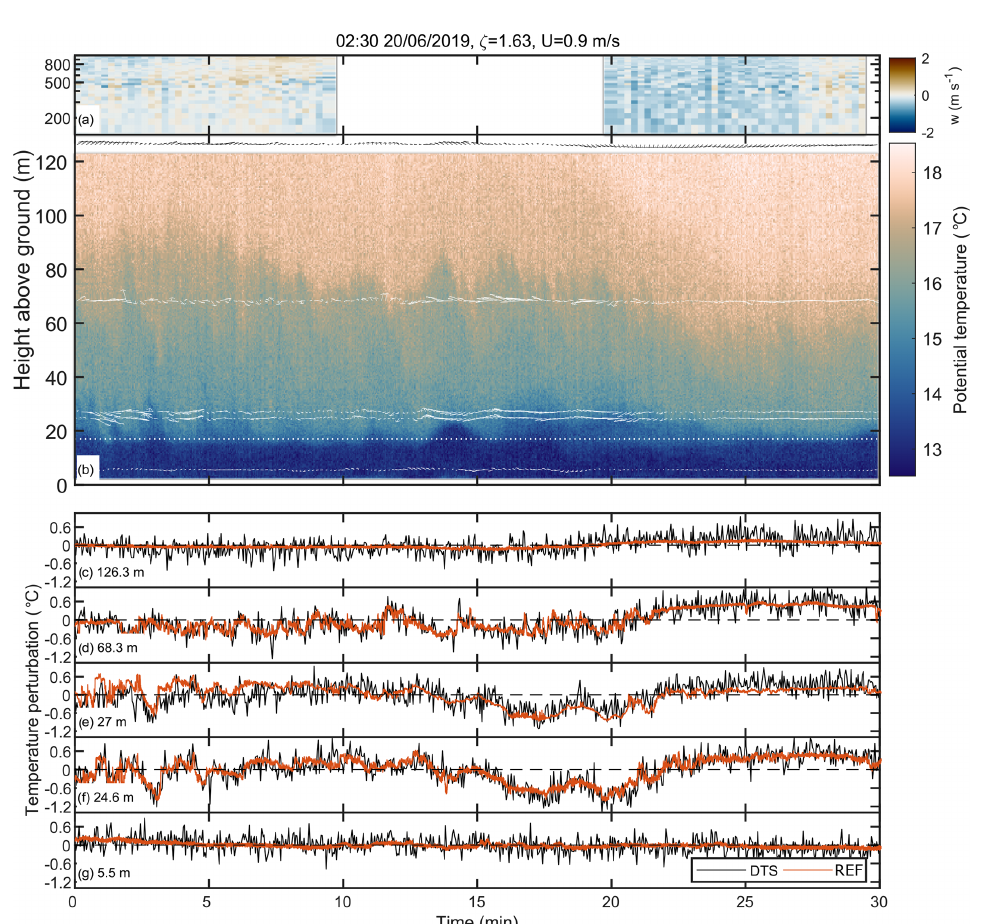
Figure 10. Same as Fig. 8 but for a strongly stable situation at